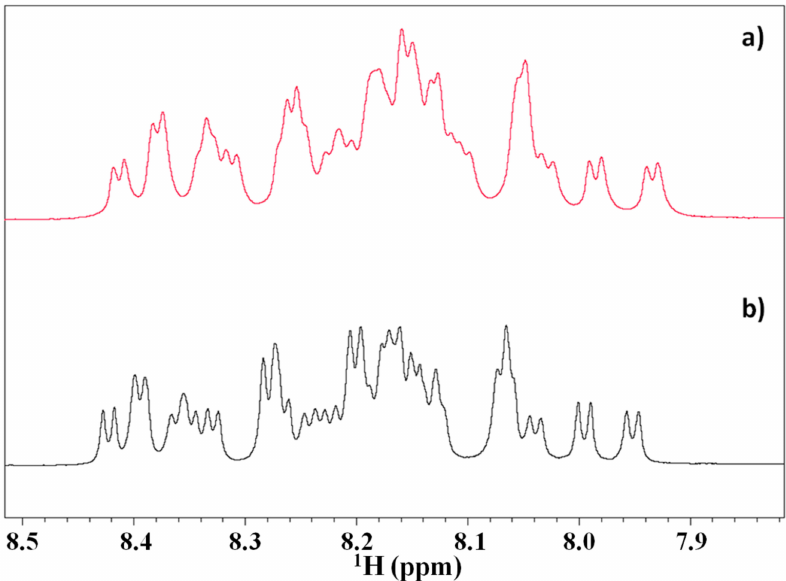
Figure 2. Amide protons region of the NMR spectra of ( a ) T α 1 in water; ( b ) T α 1 in presence of HA 0.4% ( w/w